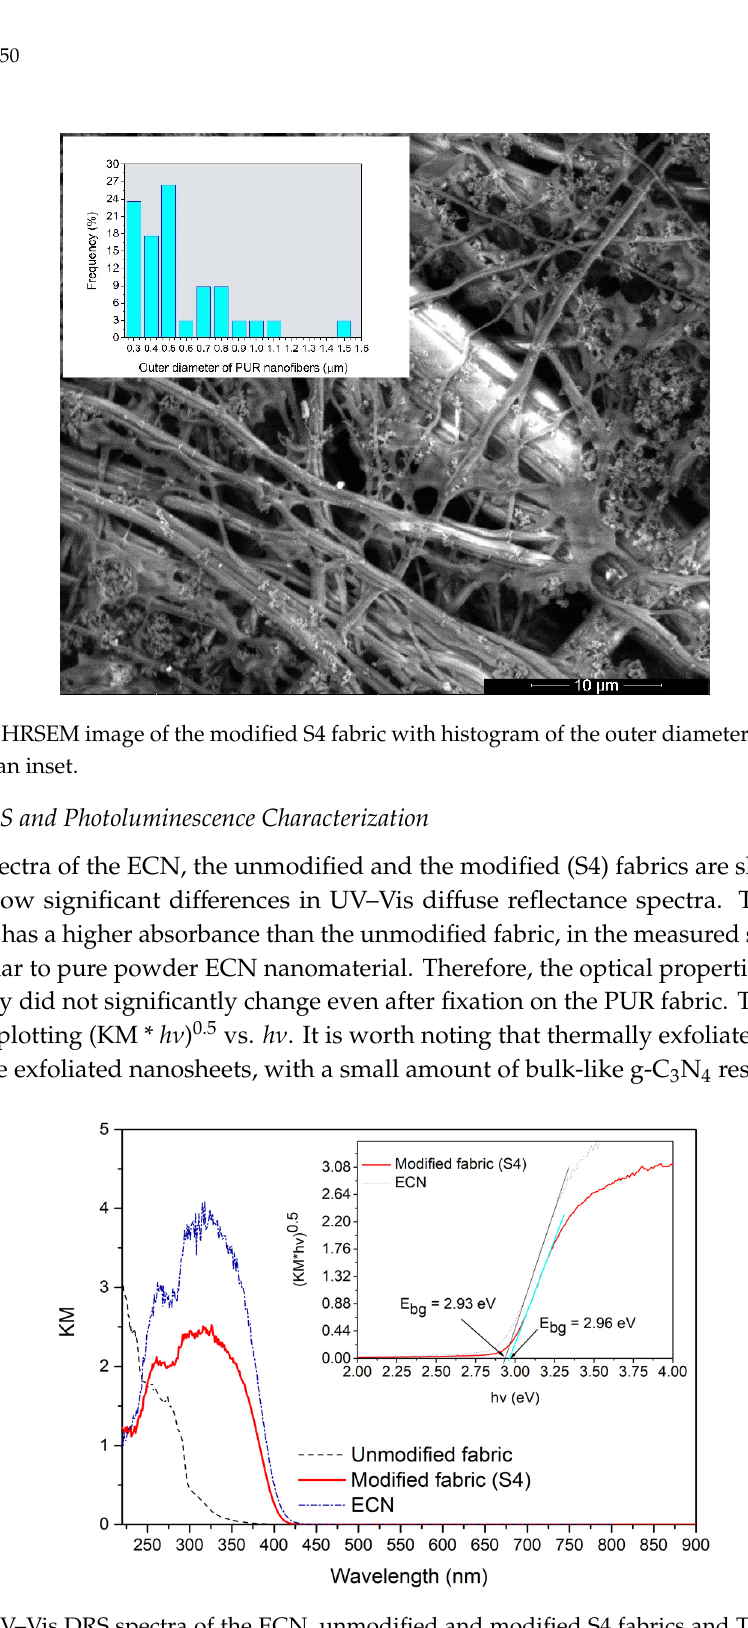
Figure 5. UV–Vis DRS spectra of the ECN, unmodified and modified S4 fabrics and Tauc plot with estimated band gap energy inserted as an inset.